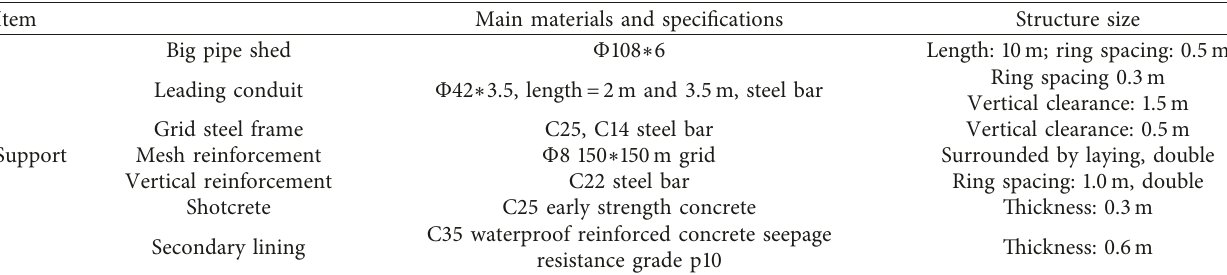
Table 2: Cross passage support